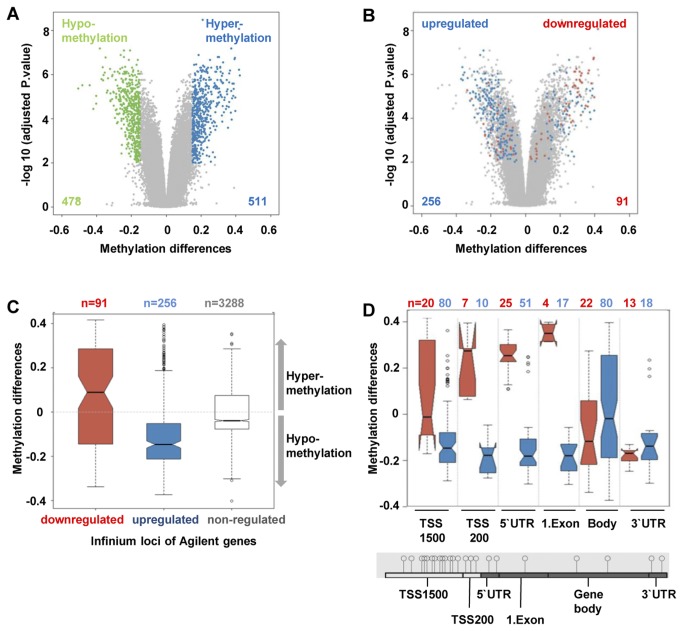
DNA methylation correlates with gene expression in abdominal and gluteal fat samples.A Mean methylation differences between abdominal and gluteal fat depot cells were plotted against Benjamini-Hochberg adjusted p values. Green indicates hypomethylation, blue indicates hypermethylation and grey indicates non-significant methylation differences; adjusted p value for significance: ≤ 0.01. B Volcano plot of log of Benjamini-Hochberg adjusted p values versus mean methylation differences between abdominal and gluteal fat samples. Red indicates CpGs corresponding to genes showing lower expression in abdominal cells (down-regulated); blue indicates CpGs corresponding to genes showing higher expression in abdominal cells (up-regulated), grey indicates non-significant differences between gene probes; adjusted p value ≤ 0.01. C,D The boxplots show the distribution and mean methylation changes of probes of down-regulated (red), up-regulated (blue) and non-regulated (grey) genes for all gene-associated CpGs (C) and for CpG loci classified according to their genomic locations (D). The numbers above indicate the numbers of probes in each category. The horizontal black lines denote medians, notches the standard errors, boxes the interquartile range, and whiskers the 2.5th and 97.5th percentiles. Mann-Whitney-U-tests indicate highly significant differences (p = 9.03 × 10-9) between methylation differences of up- and down-regulated genes.